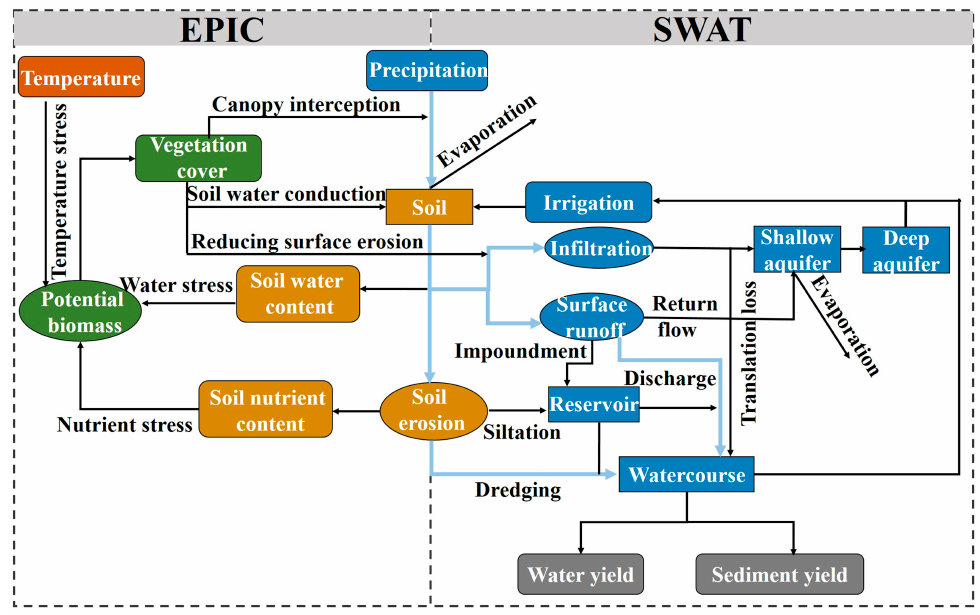
Figure 2. Structural diagram of the SWAT-EPIC model.